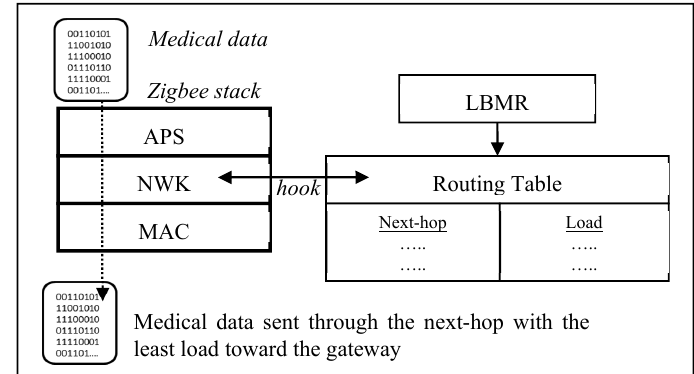
Figure 2. LBMR routing in a Zigbee stack.